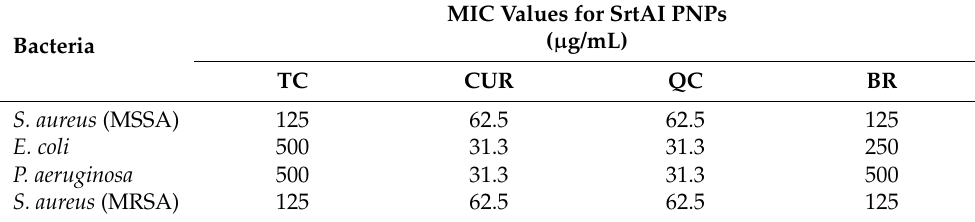
Table 1. MIC values for SrtAI-loaded (TC, CUR, QC, and BR) PNPs against a library of Gram- positive (MRSA ATCC43300 and S. aureus ATCC25923) and Gram-negative ( E. coli ATCC25922